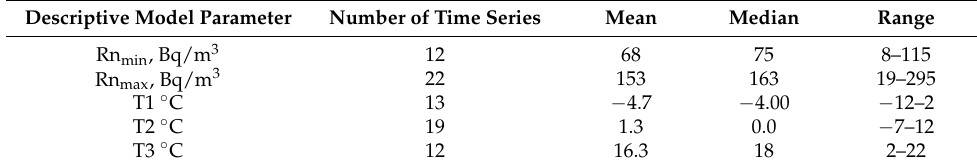
Table 7. Parameters of the